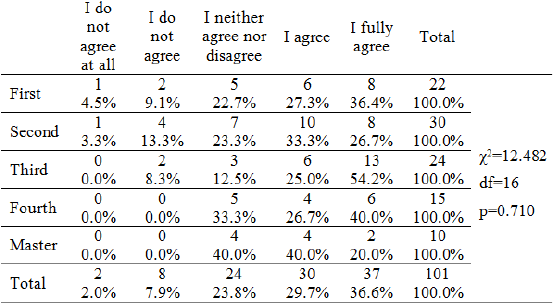
Table 7. Students’ attitude on fighting religious prejudice, by year of